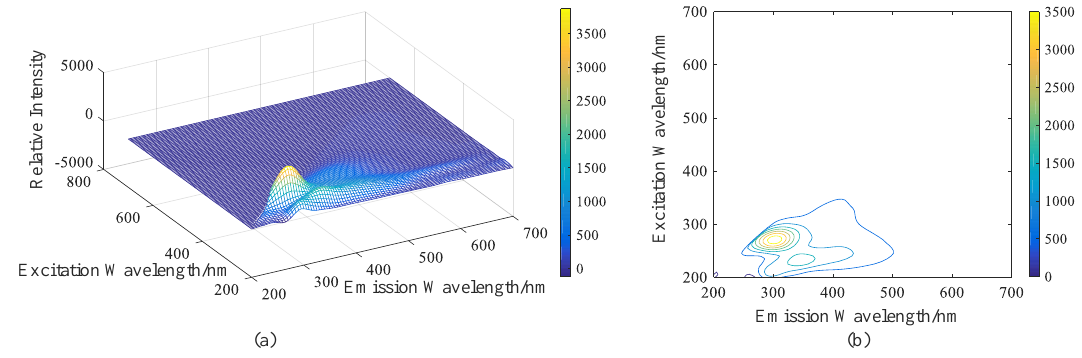
Figure 11. 3D ( a ) and contour ( b ) diagrams of 20 μg/L phenol positioning result.